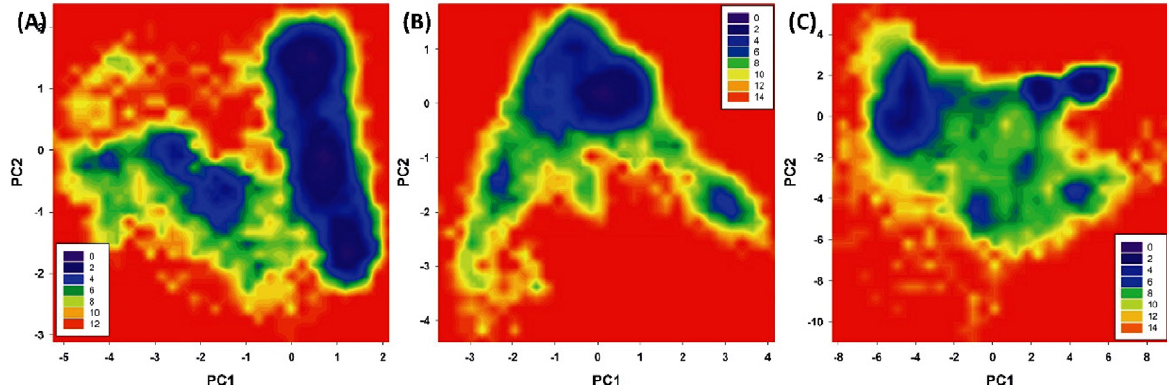
Fig. 13. Free energy landscape plot of (A) HIV-1 protease alone (B) HIV-1 protease 11630770 complex and (C) HIV-1 protease 5586894 complex.